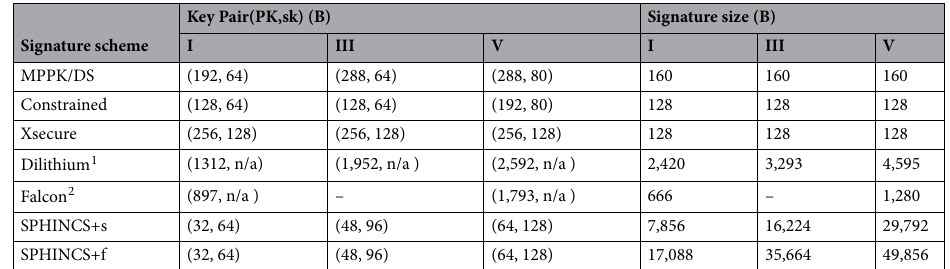
Table 4. Public key and signature sizes of the the optimized MPPK/DS scheme as well as MPPK/DS and the NIST PQC Round 3 finalists, with values given in bytes corresponding to various NIST security levels. 1 Dilithium does not provide primitive for NIST Level I, dilithium3 . was used for Level III, and